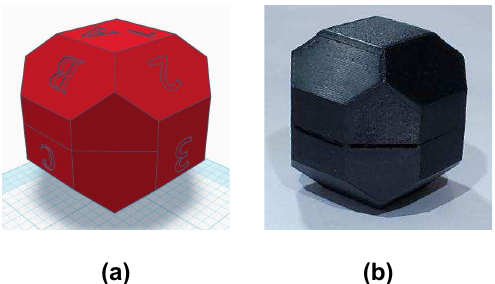
Figure 1. 3D printed polyhedron with 18 faces used for a precise positioning of the sensor. ( a ) conception of the polyhedron; ( b ) printed polyhedron.